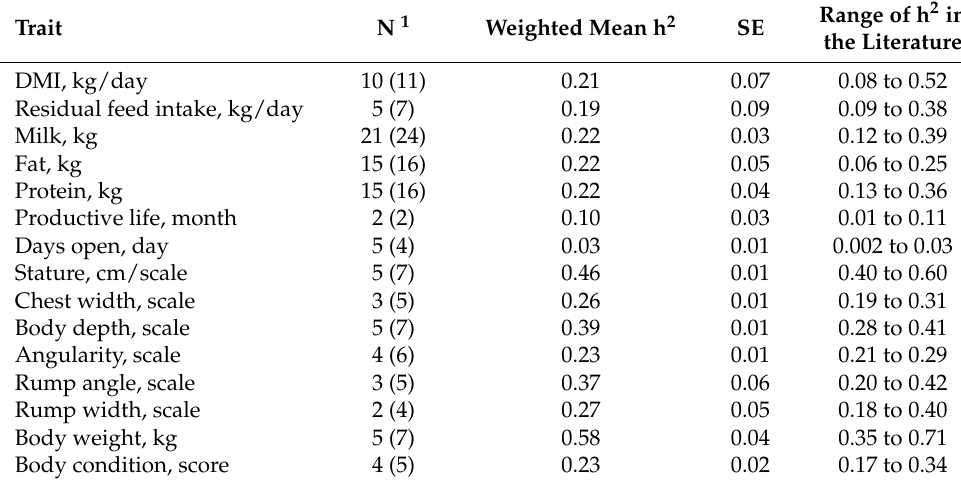
Table 1. Weighted mean heritabilities and summary statistics for feed efficiency, production, repro- duction, longevity, type, body weight, and body condition score traits calculated by meta-analysis across dairy cattle breeds and